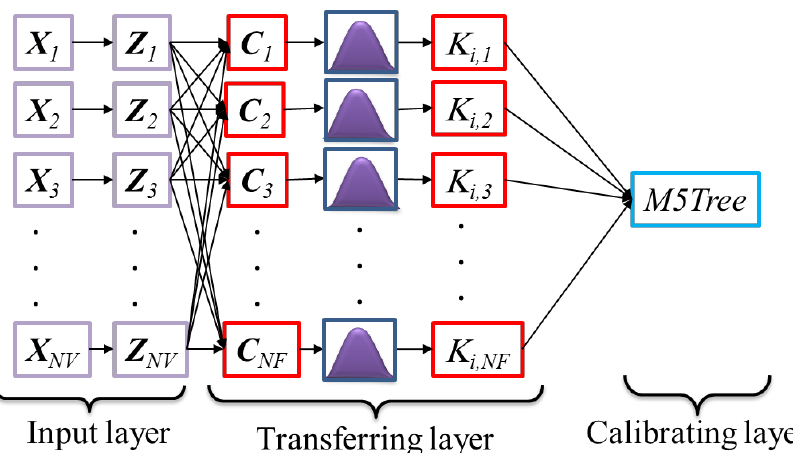
Figure 8. Schematic diagram of a radial basis RM5 tree model [74].